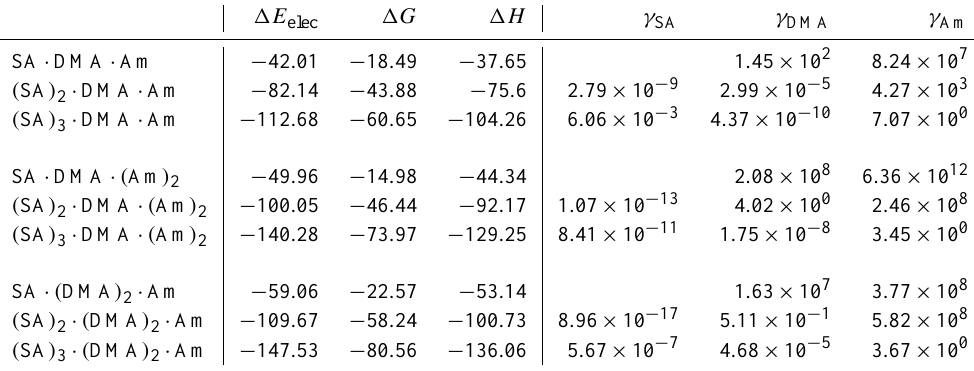
Table 3. Formation free energies (kcalmol − 1 ) and monomer evaporation rates (s − 1 ) of neutral sulfuric acid (SA) – ammonia (Am) – dimethylamine (DMA) clusters.